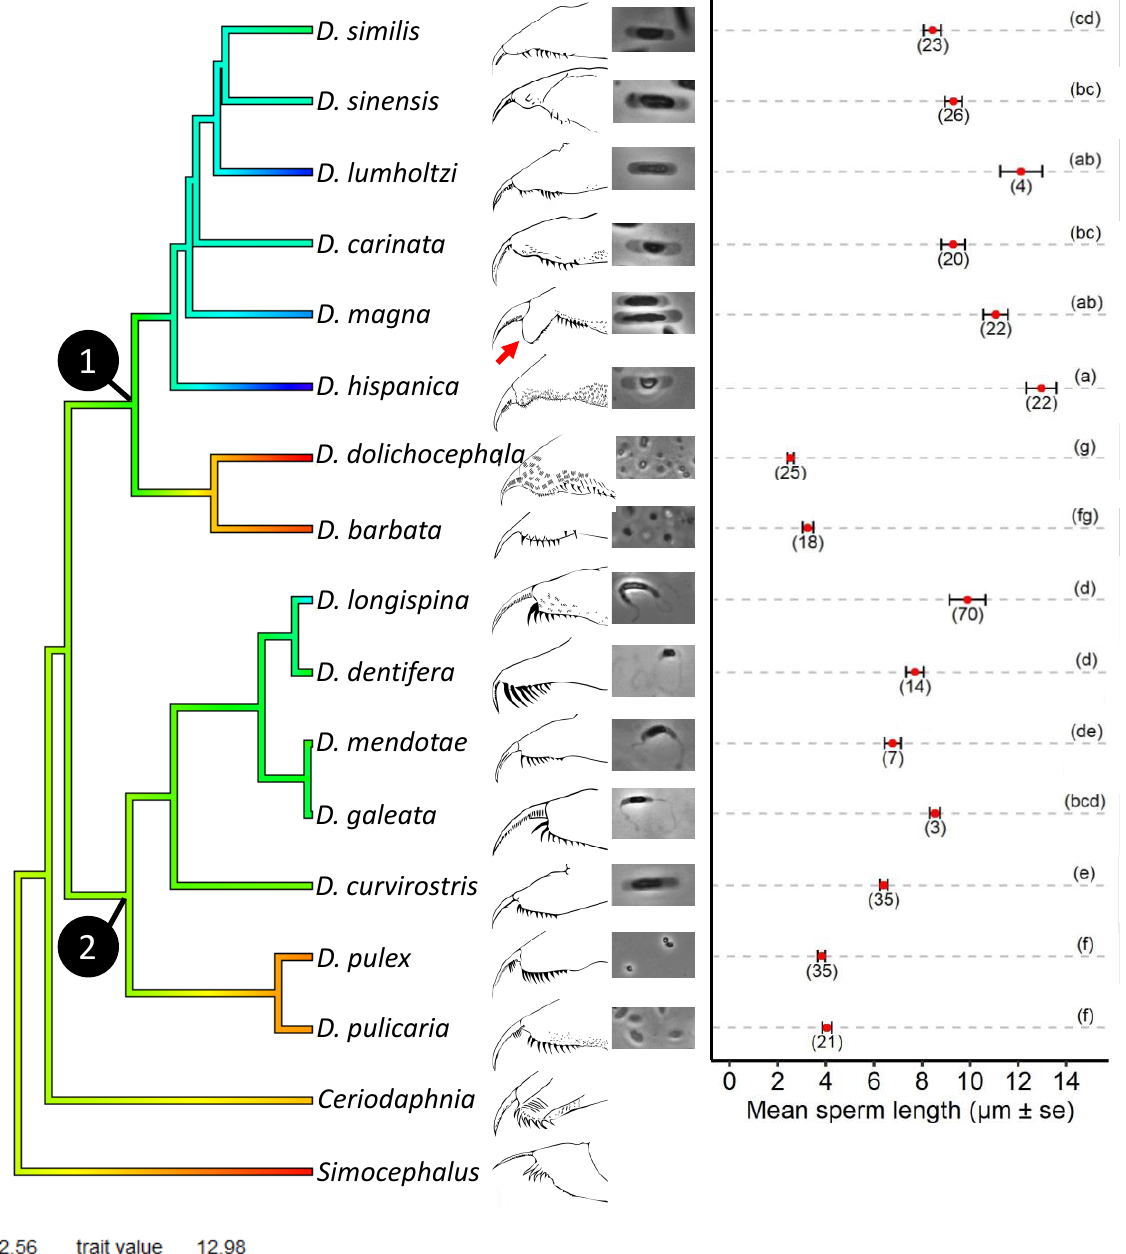
Figure 1: Evolution of sperm length and genital papilla morphology in Daphnia . Phylogenetic tree is modified from Cornetti et al. (2019) and Adamowicz et al. (2009). Color gradient represents sperm length and length of scale bar indicates to branch length in million years. Drawings represent the genital papilla of the males (redrawn from Benzie (2005) and Popova et al. (2016)). The red arrow indicates the atypical exaggerated genital papilla of D. magna . Photographs show an example of sperm for each species. The graph on the right represents the difference in sperm length among males. The mean sperm length was calculated from 2 to 3 individuals per species. Numbers under the mean represents the number of measured sperm. Letters on the right illustrates whether median sperm lengths are significantly different (different letters) or not (same letter) among species based on pairwise Kruskal-Wallis comparisons corrected for multiple testing using the FDR method. Numbers in phylogeny represent the node of the two main Daphnia clades: 1: subgenus Ctenodaphnia ; 2: subgenus Daphnia